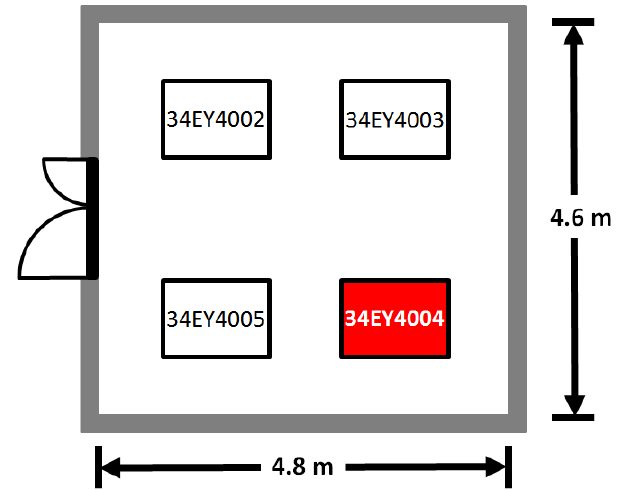
Figure 8. The high-voltage (reactor) room layout and dimensions including tag numbers and internal dimensions. The equipment that overheated is marked in red.